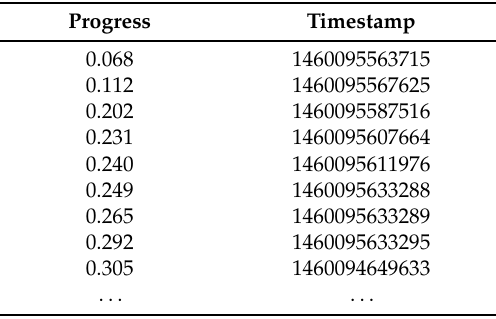
Table 4. Data Structure.